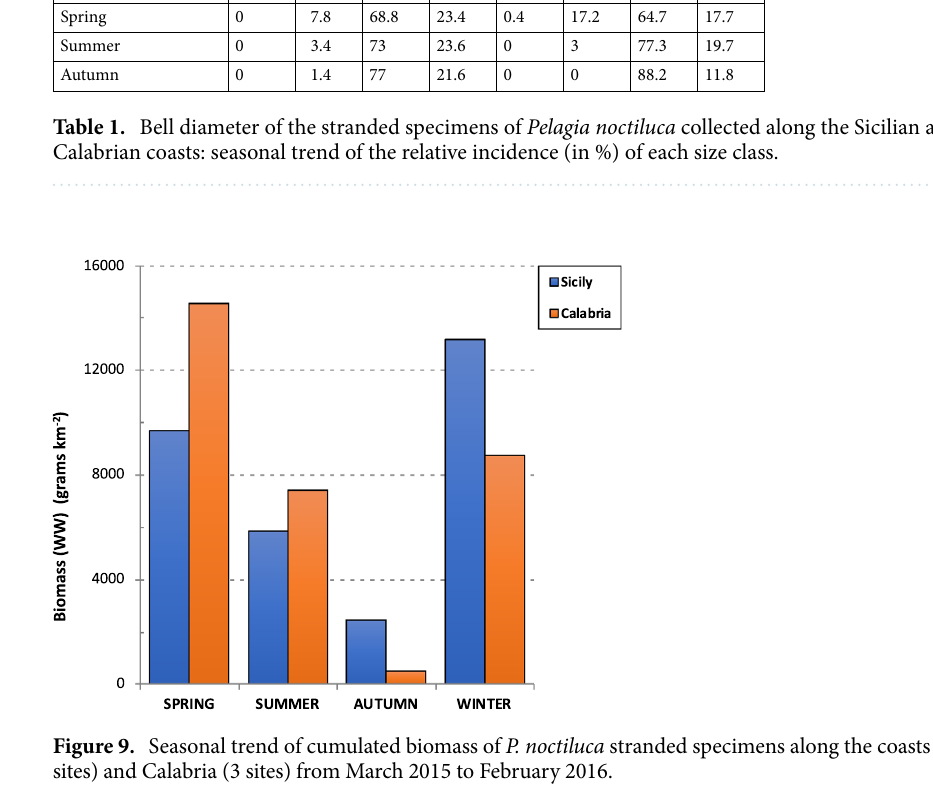
Calabrian beaches, Scilla was the one with the highest number of stranded Pelagia (43%), followed by Cannitello (35%) and P.ta Pezzo (22%). The relative frequency of stranded Pelagia on the Sicilian coast was high on days with easterly and south- easterly winds. At Faro and Ganzirri beaches, the highest number of stranded individuals was observed during southeasterly winds. Strandings at the southernmost beaches (e.g. S. Francesco) and along the Calabrian coast were mainly favoured by N/NE/NW winds. Strandings were highest at most sites during the winter and spring months (Fig. 8). They decreased in summer (July and August) and occurred in calm seas and light winds with variable directions. The stranded individuals collected were mostly damaged, colourless and usually without oral arms. The average percentage of bell diameter size classes recorded on the Sicilian and Calabrian beaches in the different seasons is presented in Table 1. The two largest stranded specimens with bell diameters of 102 mm and 124 mm were collected in January and February. The biomass of stranded P. noctiluca was estimated using the equation W = 0.0002 D 2.8786 developed for the study area 21 . W is the total wet weight in grammes, and D is the bell diameter in mm. As shown in Fig. 9, the high- est stranded Pelagia biomass was recorded on the Sicilian coast during the winter months (WW = 13,000 g, 42% of the total stranded biomass), with a decreasing seasonal trend until autumn, when the lowest value was recorded (WW = 2500 g, 8%). On the Calabrian coast, the highest biomass was obtained in spring (WW = 15,000 g, 47%), followed by similar values in winter and summer, to reach the lowest value in autumn (WW = 500 g, 2%). Although fewer beaches were considered on the Calabrian coast than on the Sicilian coast (3 versus 5 beaches), the cumulative biomass values were the same: 31,000 g WW (50%). The numerical experiments. From spawning to nursery (EXP1). The first experiment results showed that two separate spawning areas contribute a relatively high number of particles to MS. These are clearly dis- tinguishable in Fig. 10. The smaller area, located between the northern Sicilian coast and south of AIA, has a lower NSI with values between 0.7 and 0.8, while the larger area is located between the Aeolian islands of Salina, Stromboli and Vulcano and has an NSI above 0.9. The coastal waters around Lipari and Panarea have NSI values close to 1 and are therefore the most likely source of P. noctiluca in MS. The particle concentration timeline for MS is shown in Fig. 11. The first particles enter the MS about 25 days after the first release (January), and the maximum number is reached in June (day 170–175). After reaching the maximum concentration, the fraction of particles decreases until the end of the year with an almost constant rate and minimal disturbances. These results show the maximum influx of P. noctiluca in late spring and early summer and agree well with field observations. Transport time from spawning areas to MS was estimated based on particle age and is shown in Fig. 12. Particles